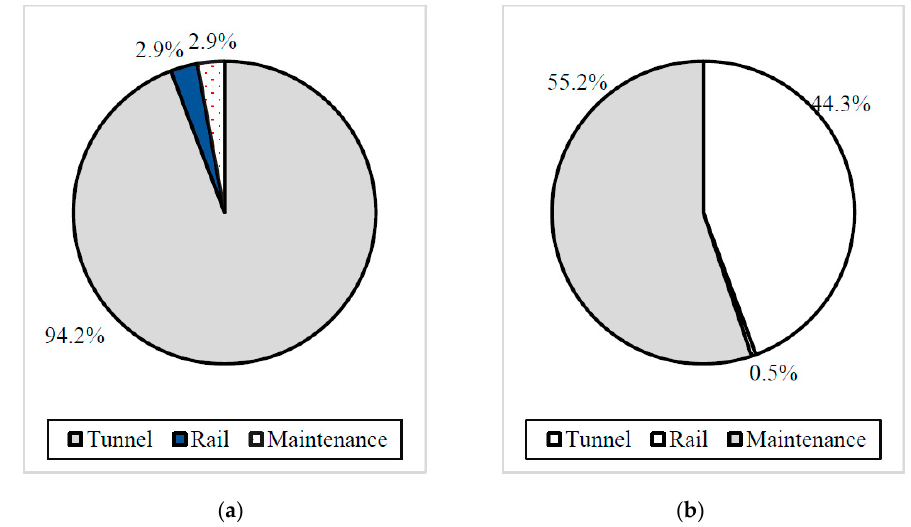
Figure 3. CO 2 emissions and energy consumption: ( a ) CO 2 emissions (ton) and ( b ) energy consumption (x10 6